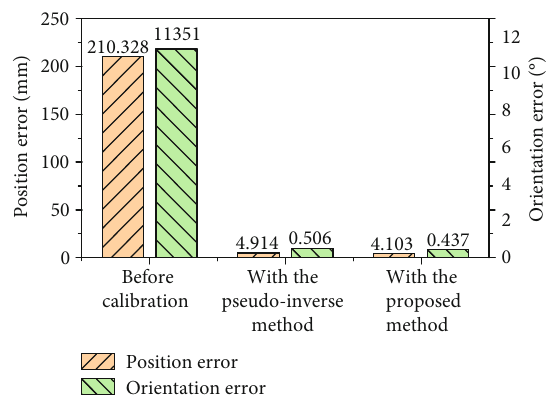
Figure 14: Pose accuracy improvements after